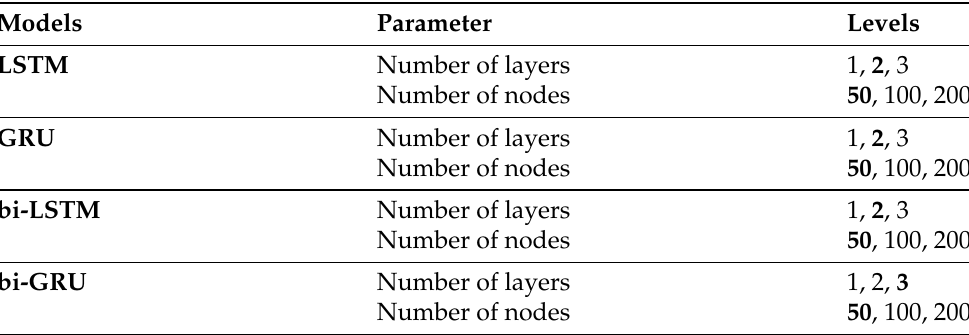
Table 7. Grid search parameters and levels for deep learning models when using raw text of the